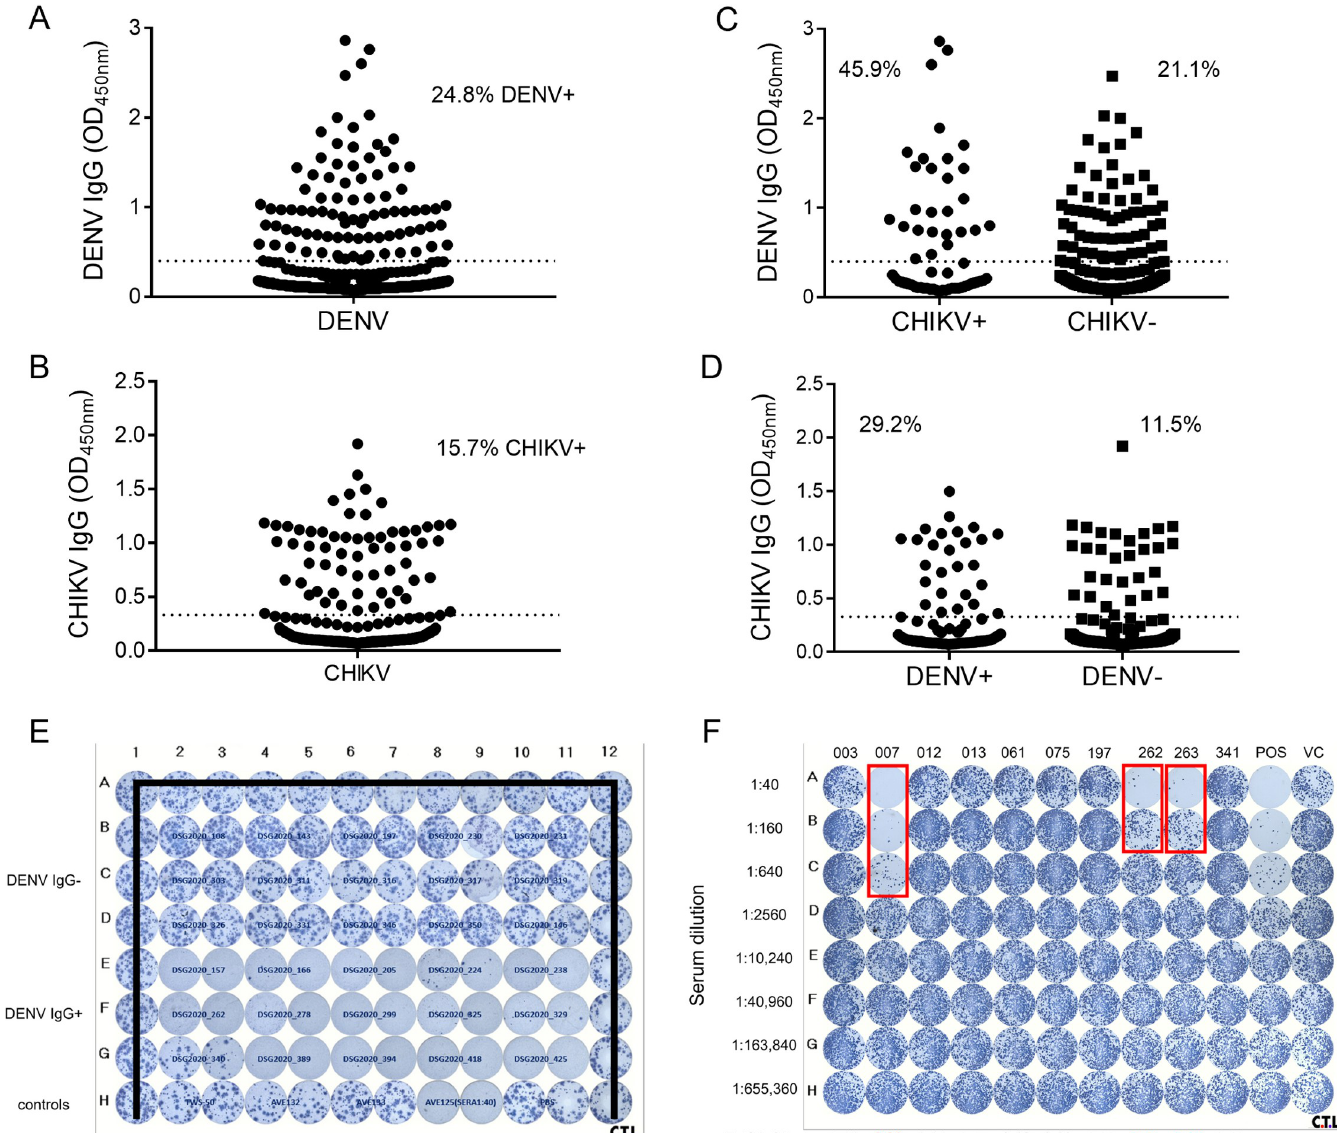
Fig 2. Seroprevalence (% shown on graph) for DENV (A, n = 387) and CHIKV (B, n = 427) by IgG ELISA are shown. The assay cutoff was determined by negative controls on each plate; a single dotted line, which is the average OD cutoff for all plates, is shown for better visualization. C) DENV IgG positivity is shown for samples (n = 383) grouped by CHIKV serostatus, and D) CHIKV IgG positivity is similarly shown for samples (n = 383) grouped by DENV serostatus. E-F) Neutralizing antibodies were assessed for DENV (E) and CHIKV (F) by focus reduction neutralization testing (FRNT). E) A subset of sera was selected based on DENV IgG serostatus (n = 15 DENV IgG- in upper portion of graph and n = 15 DENV IgG+ in lower portion of graph) and tested at a single dilution (1:80) in duplicate for neutralization of DENV2. AVE123 is a positive control (run at 1:40) and negative controls included TWS50, AVE132, and AVE133. All other wells forming the perimeter of the plate received virus only (marked through with thick bar). F) A subset of sera (n = 10) was selected based on CHIKV IgG serostatus (n = 7 CHIKV IgG- and n = 3 CHIKV IgG +) and tested over eight 4-fold dilutions in singleton for neutralization of CHIKV. CHIKV IgG ELISA results (OD, optical density) is shown across the bottom of each column, Positive ODs (OD > 0.2) are shown in